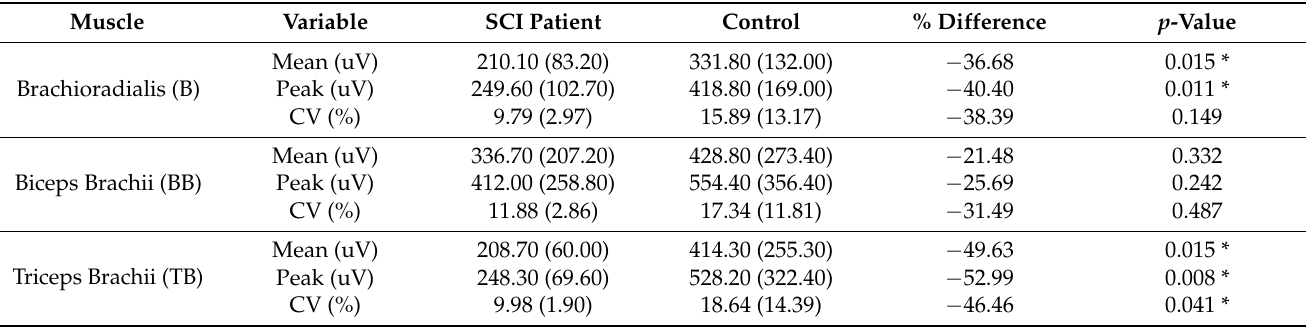
Table 3. Descriptive statistics and p -values of individual muscles associated with the elbow joint between the SCI group and the control